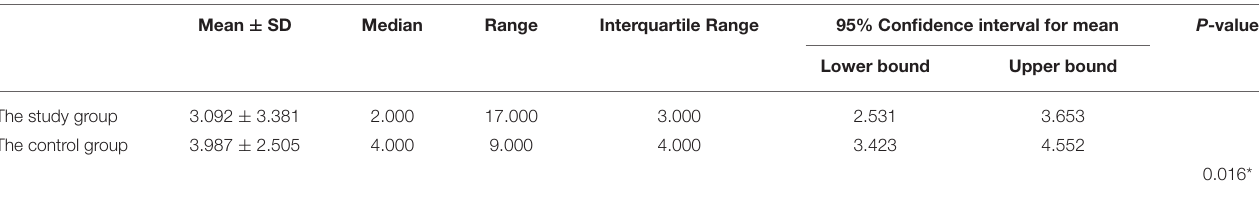
TABLE 2 | The GAD-7 scores of the study group and control group.